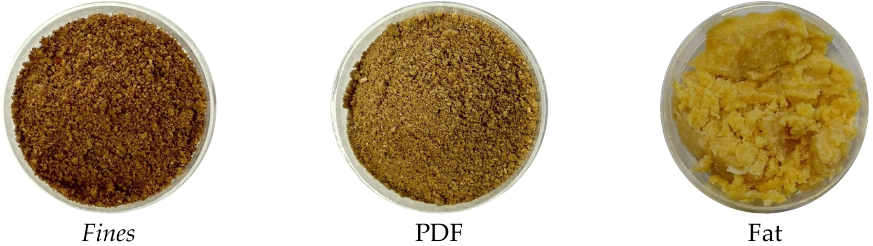
Figure 1. Fines and the fractions recovered after thermal treatment: PDF and fat.